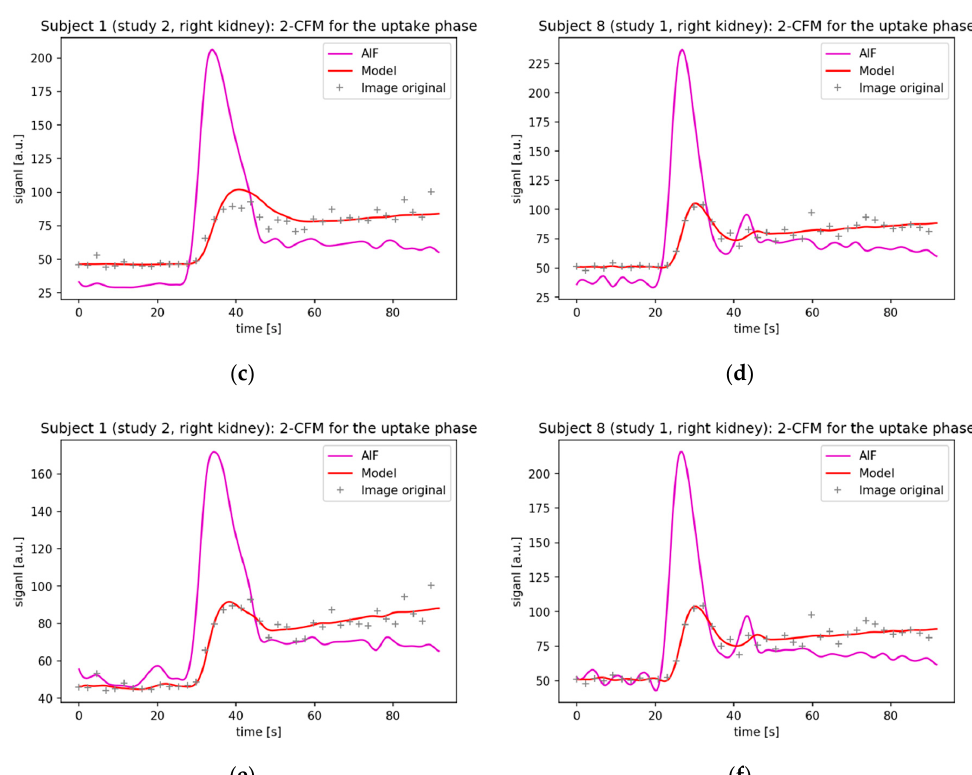
Figure 4. Examples of automatically determined arterial input function region-of-interests (ROIs) ( a ), ( b ). For comparison, manually delineated ROIs placed directly above aorta bifurcation into iliac arteries are shown as red rectangles. The corresponding fitted model curves are shown in ( c ), ( d ) for manual ROIs and in ( e ), ( f ) for the automatic ones.